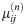
Pair of sequences (seq) are compared with each other and the VJ(ℓ)-group effective germline (EGL) to identify unique and shared somatic hypermutation events.The effective germline sequence is determined by IUPAC character representation of all the nucleotides present at each position across all germlines in a given VJ(ℓ)-group (allele-grouping). Each nucleotide position of ith and jth sequences is compared with the corresponding nucleotide position in the effective germline and somatic hypermutation events are flagged with binary variables: (1) α: a single mutation which occurs only in one of the sequences, (2) β: two unique mutations which occur in both sequences, and (3) γ: a shared mutation which occurs in both sequences. The average of the mutabilities of the germlines (GLs) 5-mer motifs in which a shared mutation occurred at the central position is shown by μij(n), where superscript n indicates the position that mutation occurred. Mutation events are bold and underlined in the sequences.